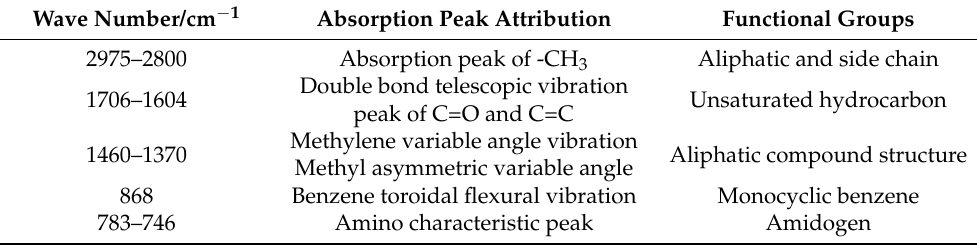
Table 2. Main vibrational peaks in infrared spectra.